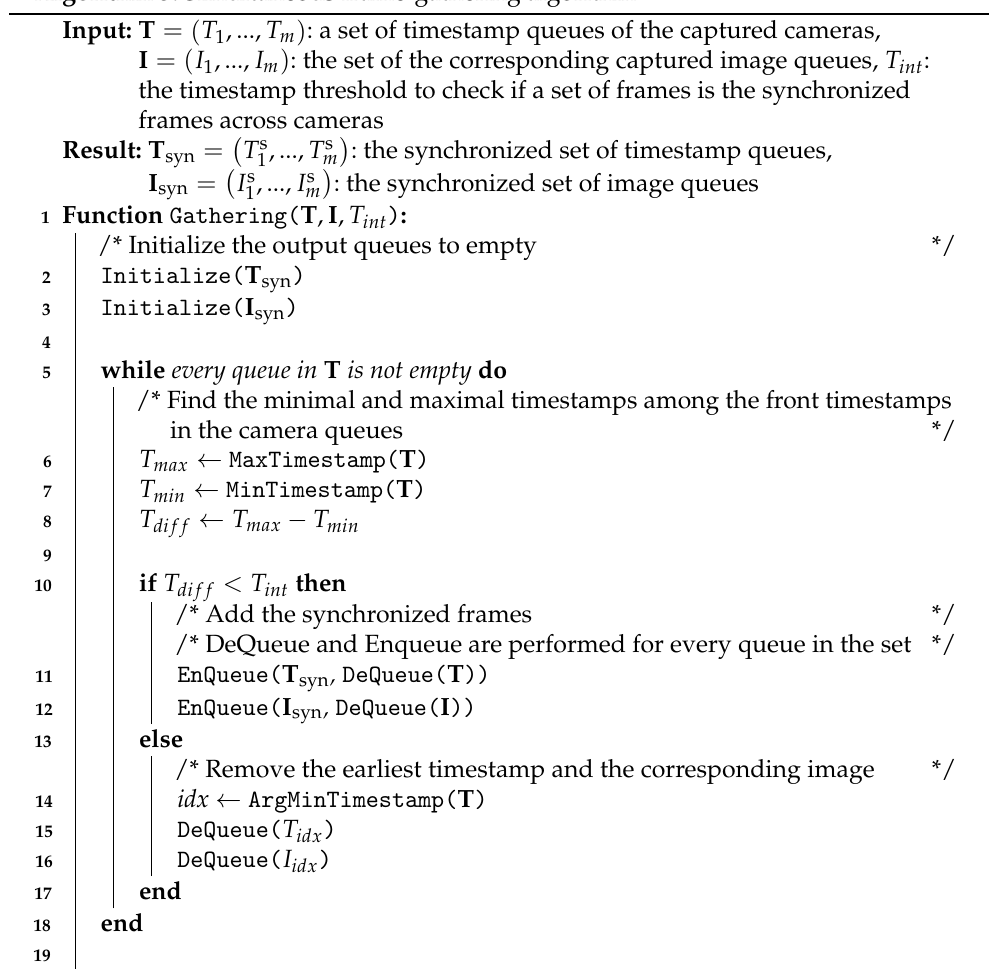
Algorithm 3: Simultaneous frame-gathering